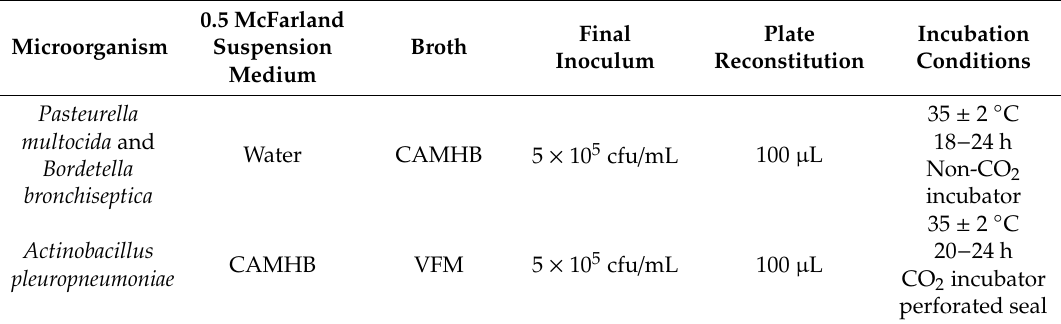
Table 4. Details of the conditions used to carry out minimum inhibitory concentration (MIC) determination using the broth microdilution method by means of customized 96-well microtiter plates (Sensititre, Trek diagnostic Systems Inc., East Grinstead,